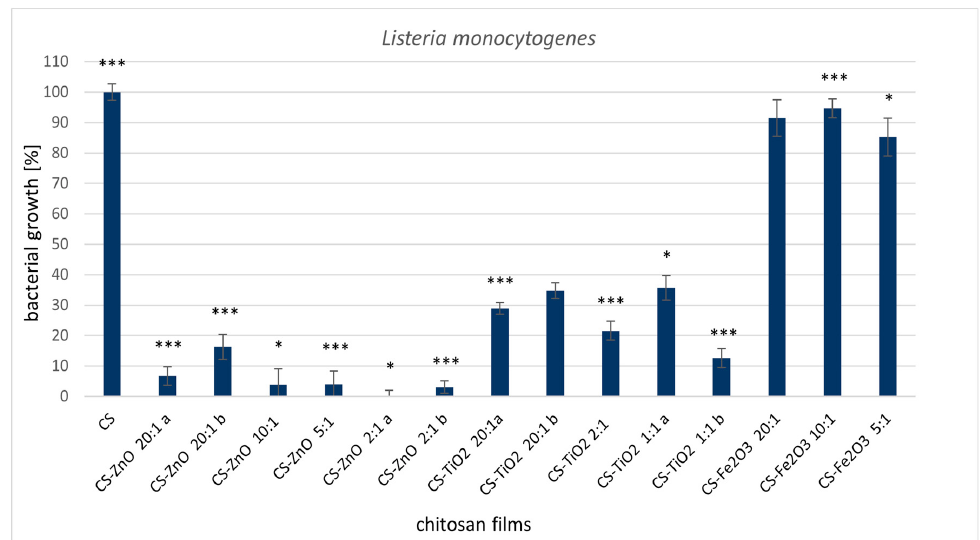
Figure 1. Reduction of Listeria monocytogenes ATCC 15313 with treatments with metal-oxide chitosan films after 24 h incubation. The value from control group (CS) was set as 100%. Statistical significance is marked in relation to the chitosan nanocomposite (CS) ( n = 6, * p < 0.05, *** p < 0.001).